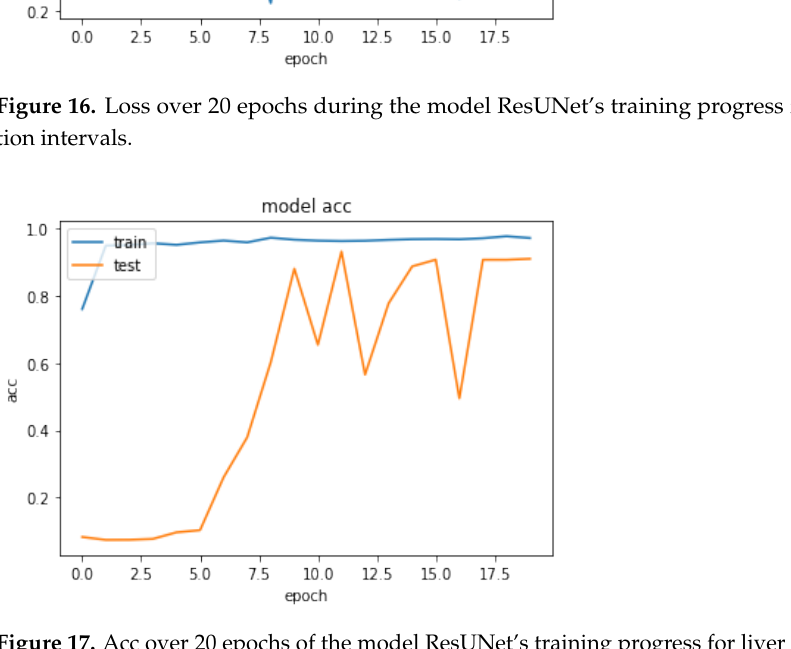
Figure 17. Acc over 20 epochs of the model ResUNet’s training progress for liver segmentation inter- vals.